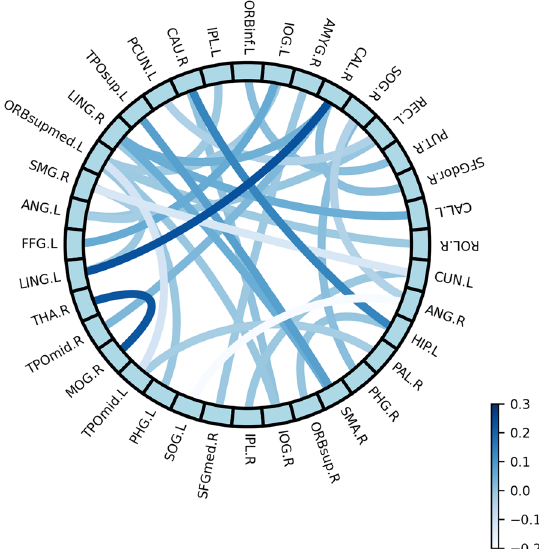
Fig. 8 Selected features based on w